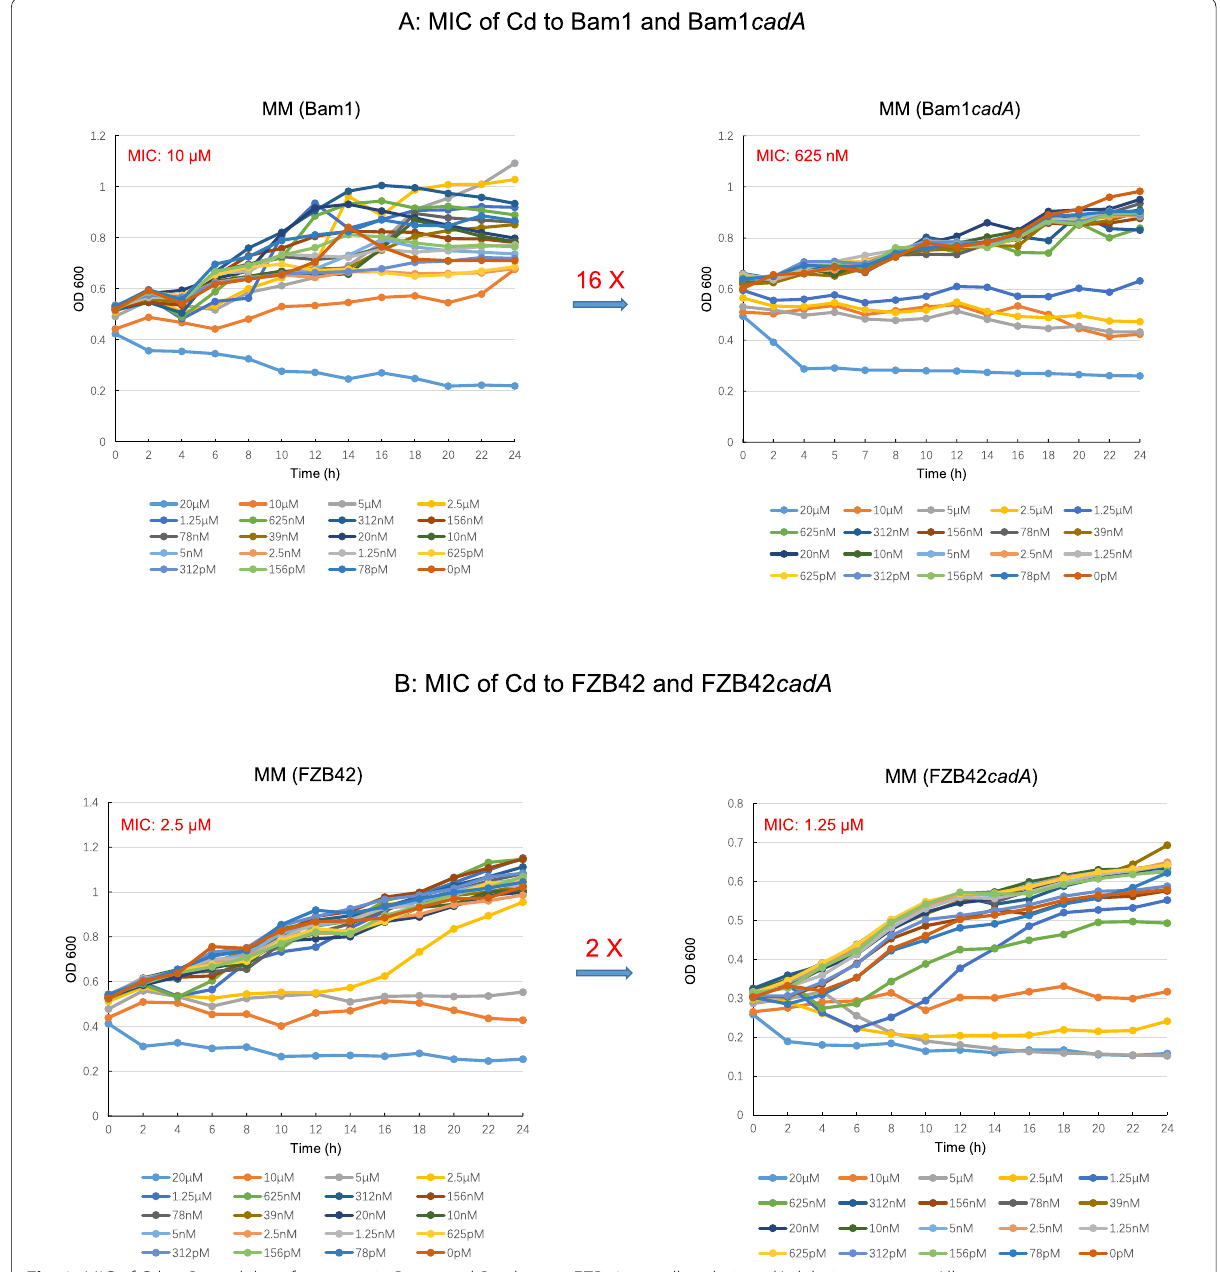
Fig. 8 MIC of Cd to B. amyloliquefaciens strain Bam1 and B. velezensis FZB42 as well as their cadA deletion mutants. All measurements are mean SEM ( n ± =